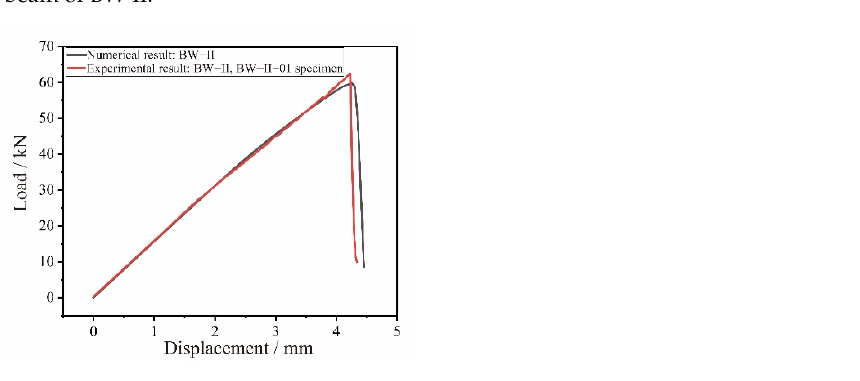
Figure 30. Comparison of the experimental and numerical load-displacement curves for the compo- site beam of BW-II.